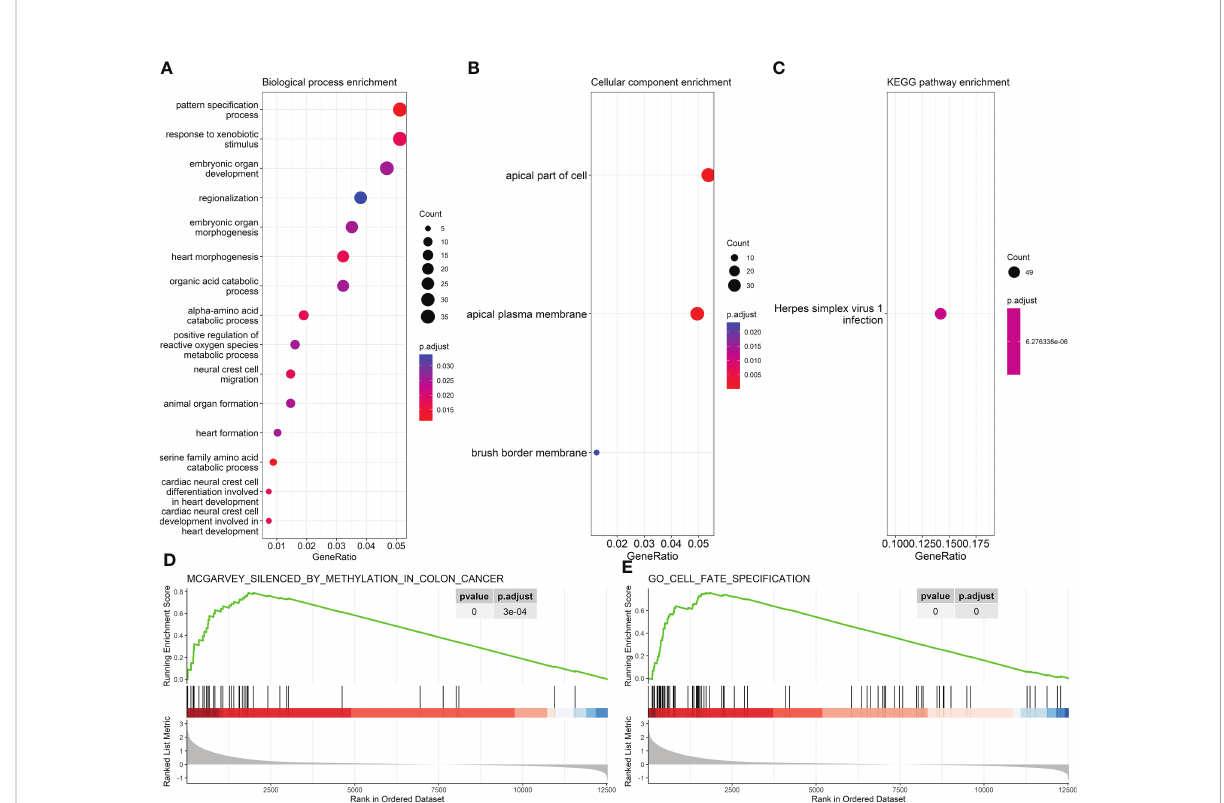
FIGURE 1 Enrichment results of 761 methylation-driven genes (MDGs). (A, B) GO enrichment analysis. (A) Biological process. (B) Cellular component. (C) KEGG pathway enrichment analysis. (D, E) Representative results of GSEA. GO, Gene Ontology; KEGG, Kyoto Encyclopedia of Genes and Genomes; GSEA, Gene Set Enrichment